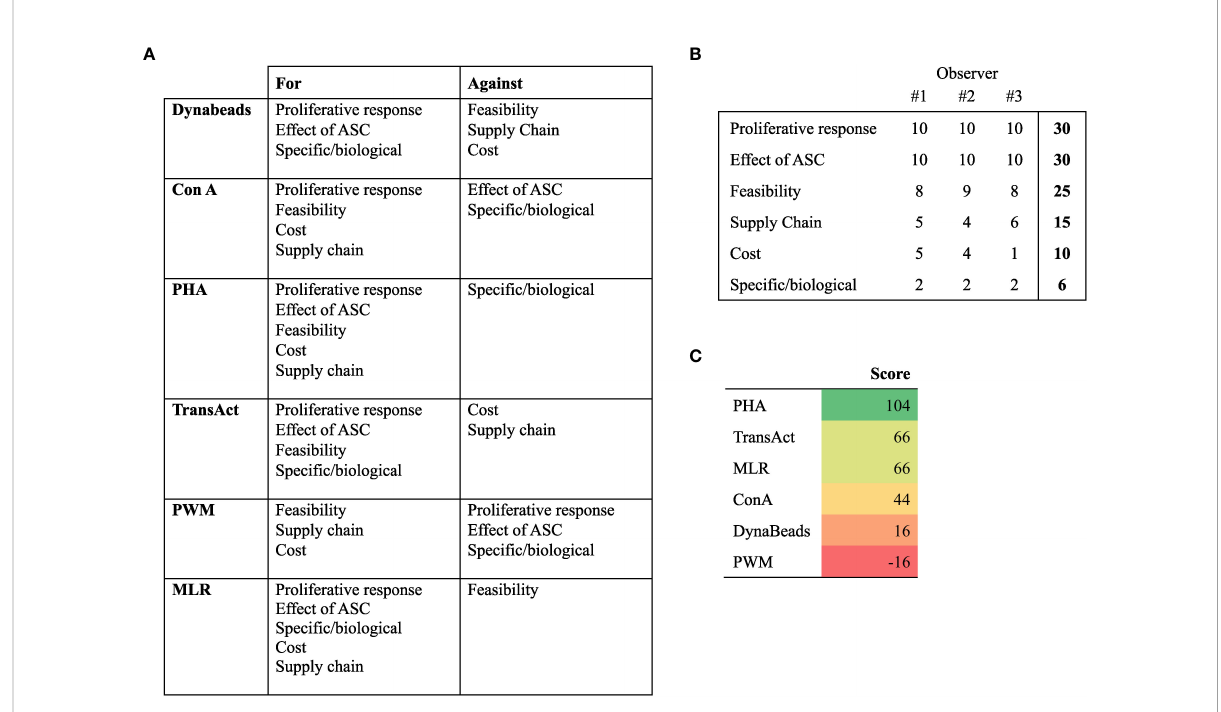
FIGURE 5 Rankings of mitogens and MLR to determine their suitability for lymphocyte proliferation potency assay. (A) Distribution of terms for or against a given mitogen or MLR. (B) Weight attributed to terms, ranging from 10 (very important) to 0 (not important). The sum of 3 observers is used to compute the score. (C) Score of mitogens derived from subtracting terms against from terms for. PHA, Phytohemagglutinin; ConA, Concanavalin A; ASC, Adipose Tissue-derived Stromal Cells; MLR, Mixed lymphocyte